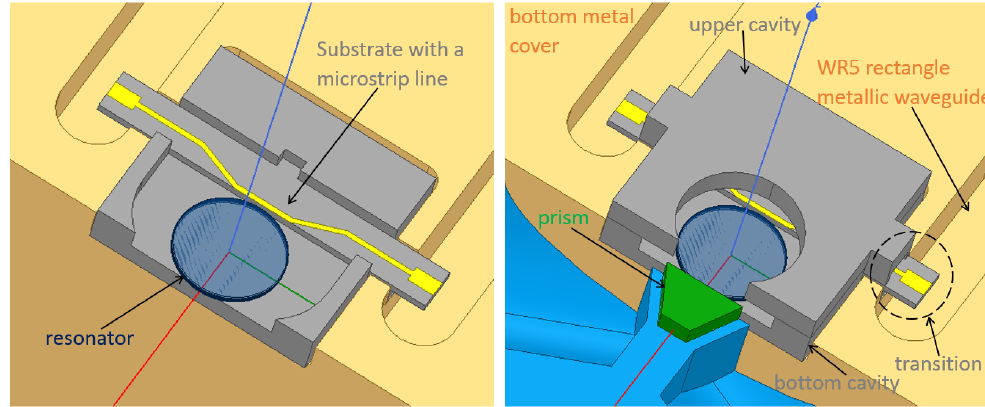
Figure 10. Coupling of the signals into the resonator in the upconversion scheme: left shows the millimeter-wave coupling structure only; right shows both millimeter-wave and